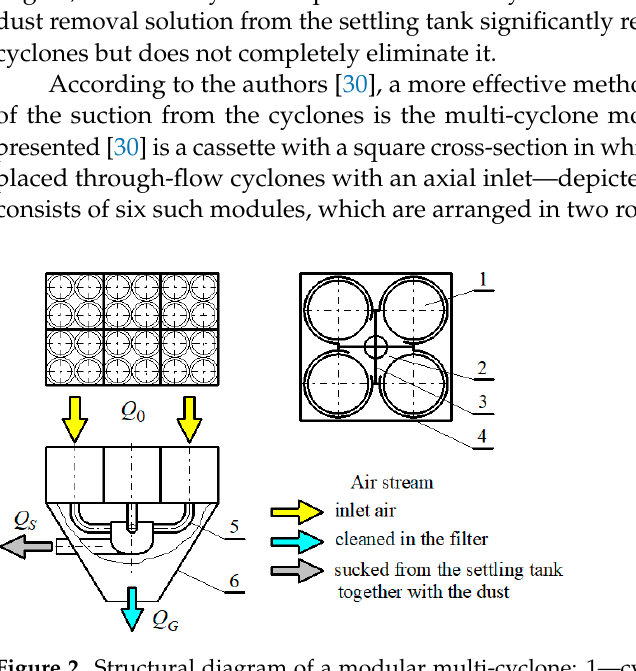
Figure 2. Structural diagram of a modular multi-cyclone: 1—cyclone, 2—dust trap, 3—partition, 4—module cassette, 5—suction pipes, 6—exhaust air collector [30].